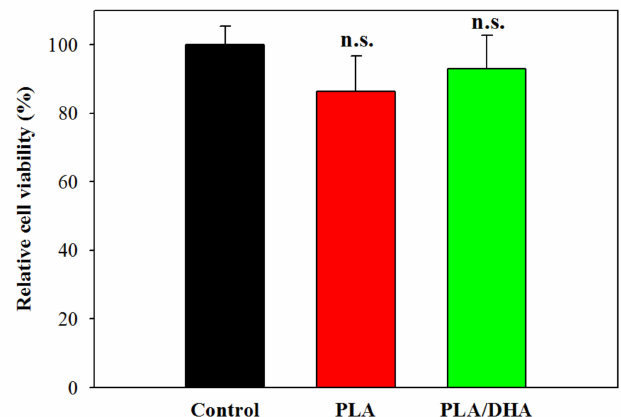
Figure 6. Evaluation of the cytotoxicity of core-shell nanofiber membrane toward fibroblasts using the 24 h extraction medium of polylactic acid (PLA) or polylactic acid / docosahexaenoic acid (PLA / DHA) core-shell nanofiber membrane for the culture of fibroblasts ( n = 6, mean ± SD). The control is cells cultured with fresh cell culture medium. The cell viability was determined using the MTS assay and normalized to the control. n.s., not significant compared to control ( p >